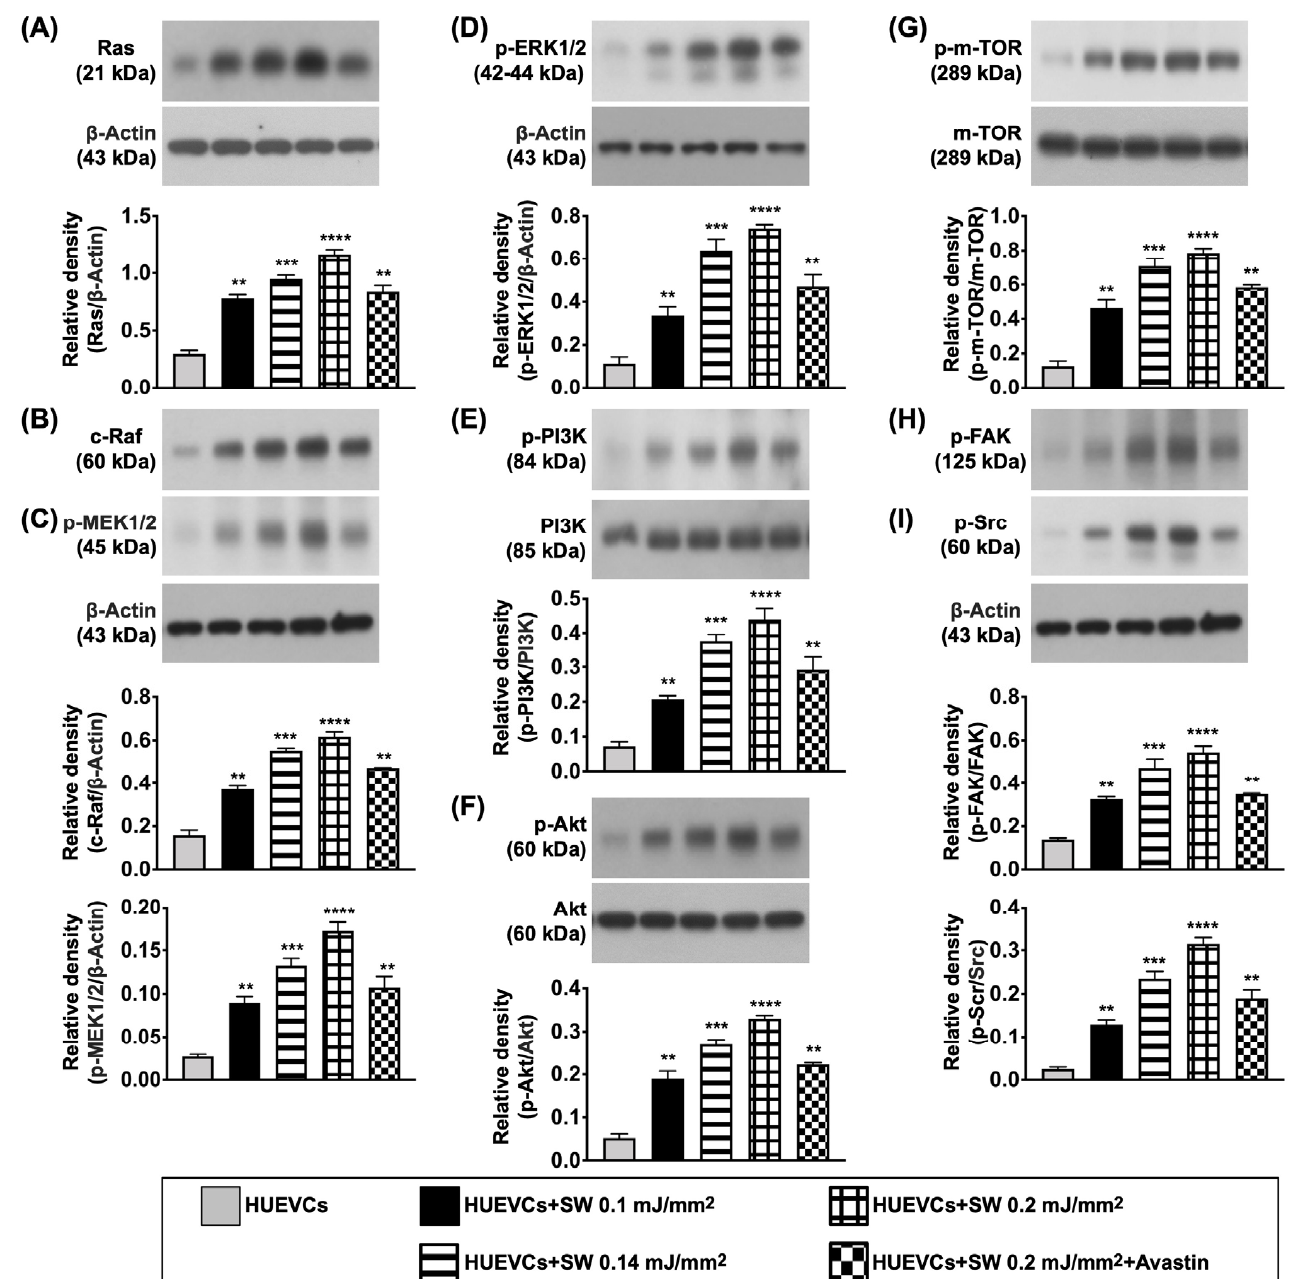
Figure 3. Protein expressions of cell proliferation/growth/survival, and cell motility signalings . ( A– I ) Western blot analyses showed the results of protein expressions of Ras ( A ), c-Raf ( B ), phosphor- ylated (p)-MEK1/2 ( C ), p-ERK1/2 ( D ), p-PI3K ( E ), p-Akt ( F ), p-m-TOR ( G ), p-focal adhesion kinase (FAK) ( H ) and p-Scr ( I ). “*” represents in comparison with the control, ** for p < 0.01, *** for p < 0.001, **** for p < 0.0001. n = 4 for each group. HUVECs = human umbilical vein endothelial cells; SW = shock wave.